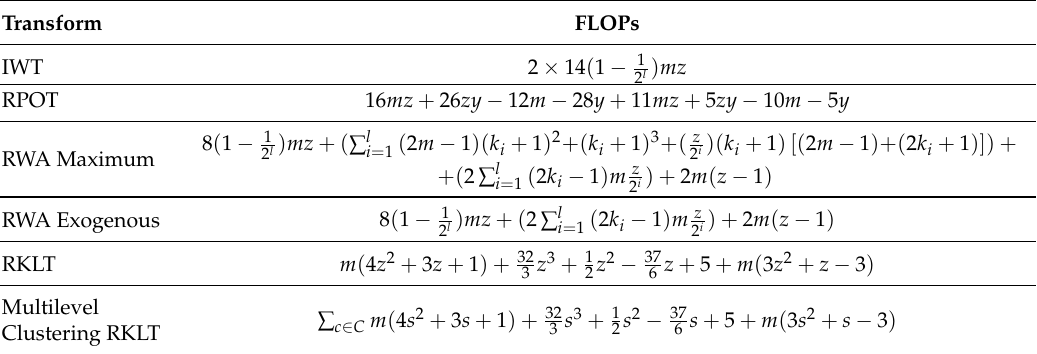
Table 5. Computational cost in FLOPs for IWT, RPOT, RWA Maximum, RWA Exogenous, RKLT, and Multilevel Clustering RKLT. z is the number of spectral channels, m is the number of spatial samples per channel, y is the number of rows, l is the number of wavelet decomposition levels, k is the number of detail channels employed in the prediction level i [38], s is the number of spectral channels per cluster ( s (cid:28) z ), and C is the total number of